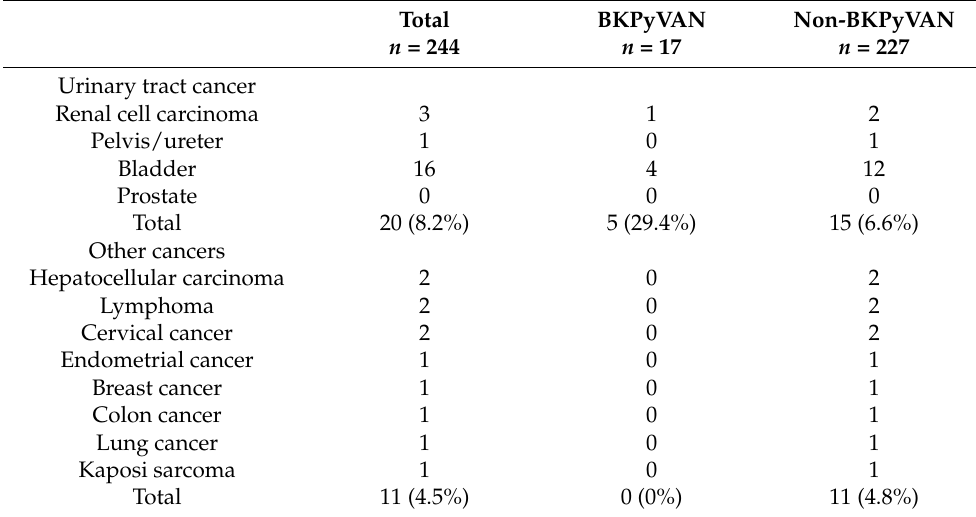
Table 2. Subtypes of cancers in kidney transplant recipients with/without